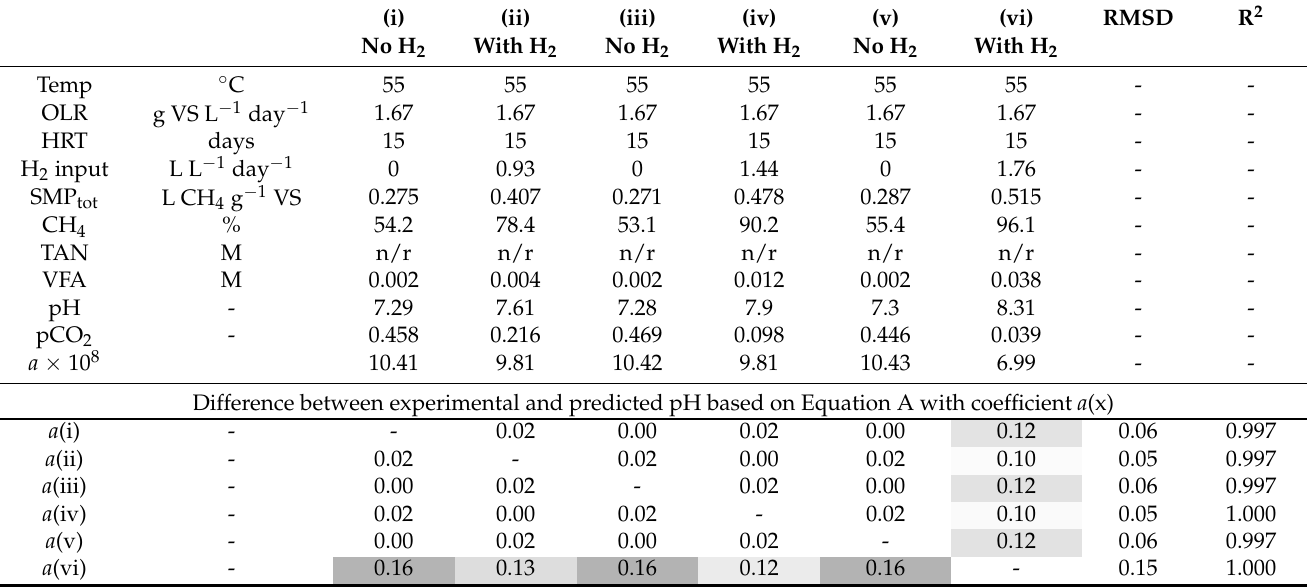
Table 1. Performance of Equation A for reported average values from Luo and Angelidaki